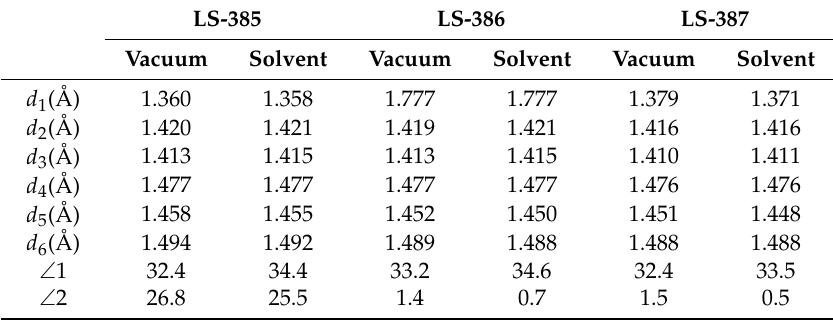
Figure 1. ( a ) shows molecular structures and names of LS-385, LS-386, and LS-387; ( b ) shows the ground-state optimized geometry by DFT calculations performed at the 6–31G(d) level. Table 1. bond lengths (Å) d 1 to d 6 and dihedral angles ( ◦ ) of dyes in vacuum and DMF solvent, respectively.